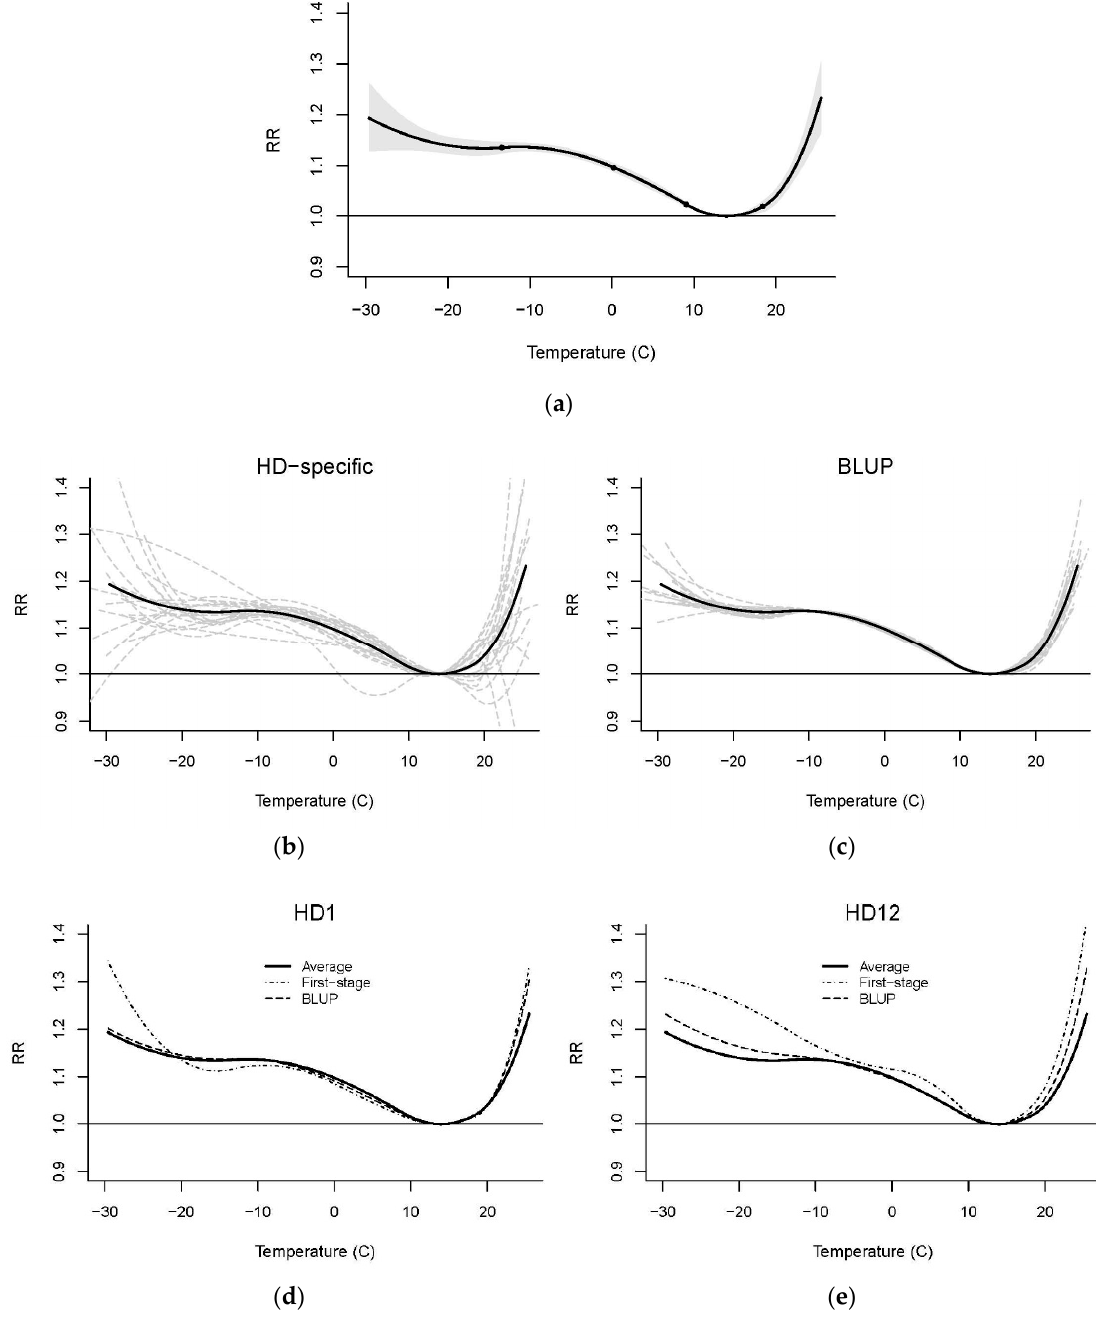
Figure 2. Temperature-mortality relationships based on the model without lag. ( a ) Pooled, average relationship (solid curve) with 95% confidence interval (shaded), dots indicating location of knots (up), relative risk (RR) reference at T = 14 ◦ C; ( b ) hospital district (HD)-specific models (dash curves) with the pooled relationship (solid curve); ( c ) best linear unbiased predictions (BLUP) estimations for hospital districts. Examples on how BLUP estimation pulls the relationships towards the average in two hospital districts: ( d ) HD1, in southern Finland and ( e ) HD12, in eastern Finland.